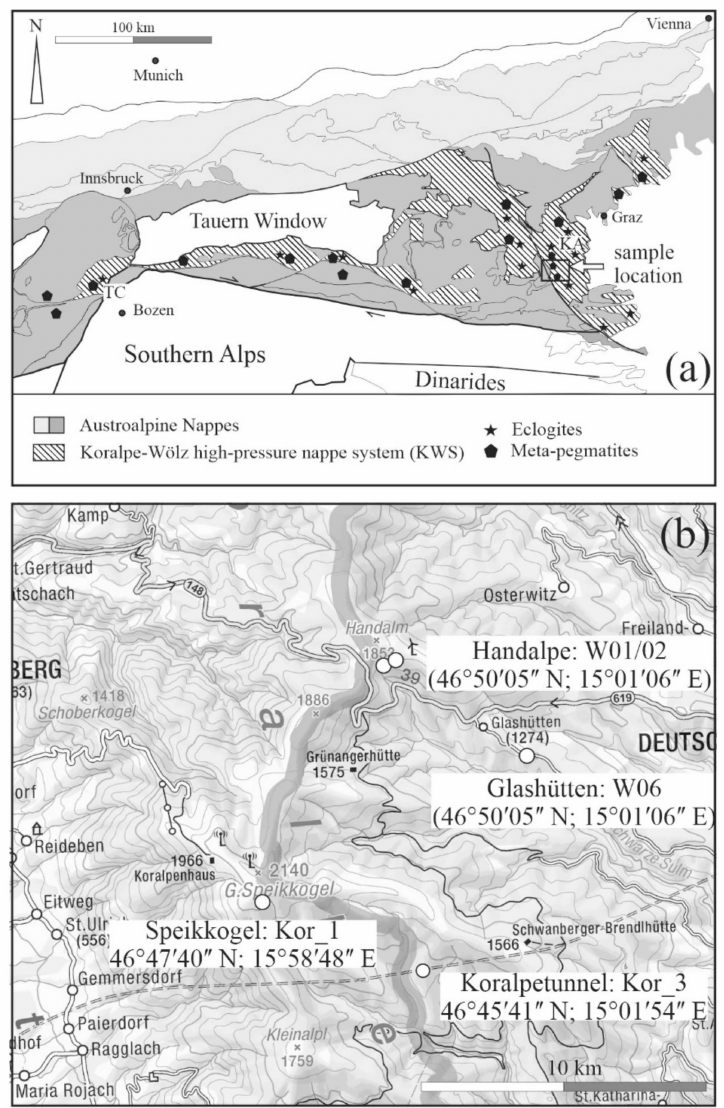
Figure 1. ( a ) Simplified geological map of the Eastern Alps and its surroundings showing locations of meta-pegmatites and eclogites as well as the location of garnet-bearing meta-pegmatite samples in the Koralpe Mountains (KA). TC: Texel Complex. ( b ) Sample location map and their respective GPS data. Topography taken from AMAP Online